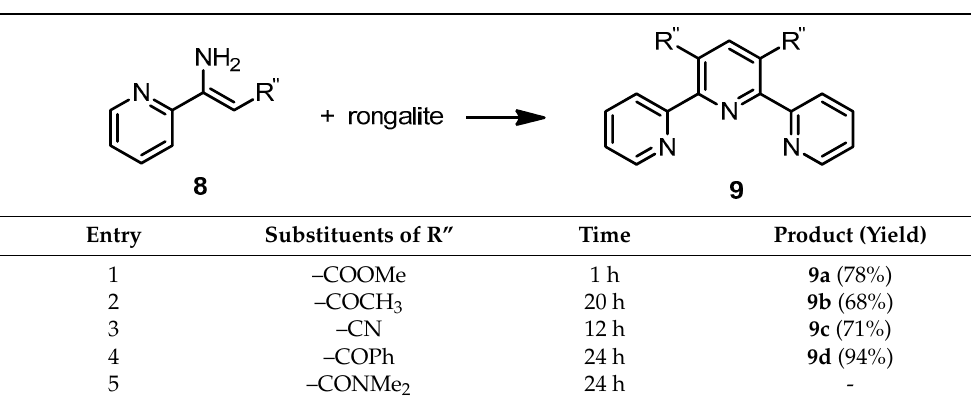
Table 3. Preparation of terpyridines 1 .